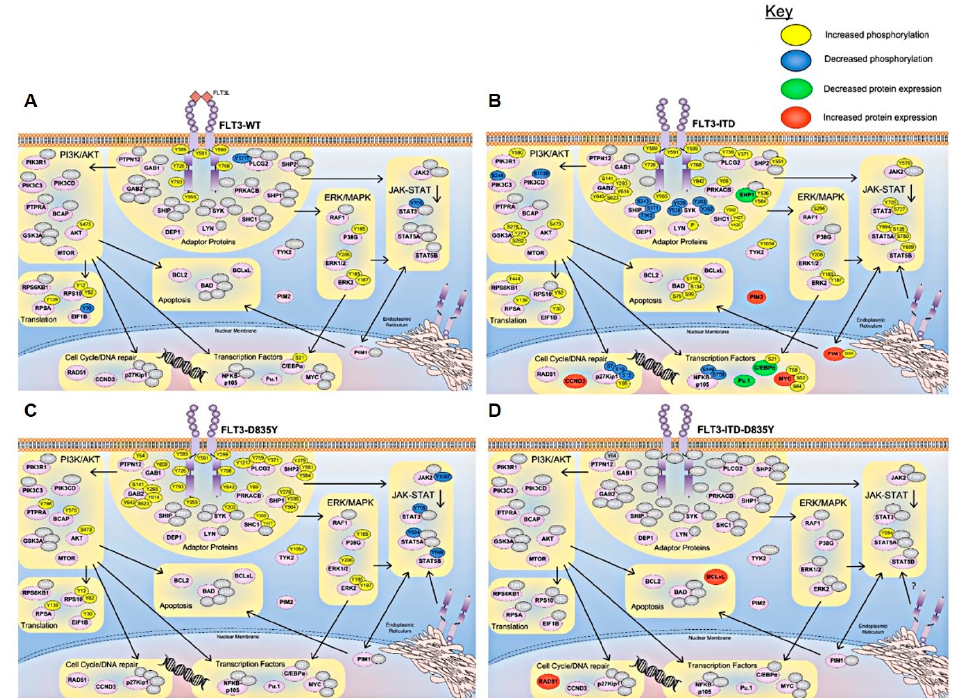
Figure 2. Canonical FLT3 and mutant FLT3 signaling pathways. Similar and divergent signaling pathways of wild-type and mutant FLT3 identified by functional genomic studies and large scale proteomic profiling experiments. ( A ) Upon binding of the FLT3 ligand (FLT3L), the FLT3 receptor undergoes a change in conformation and trans-autophosphorylation. ( B ) FLT3-ITD, ( C ) FLT3-TKD and ( D ) FLT3-ITD-TKD dual mutations lead to constitutive, ligand independent activation of the FLT3 receptor. Subsequent recruitment of adaptor proteins effects the activation of downstream kinase signaling pathways, such as MAPK, JAK-STAT, and PI3K. Coloring indicates activation of pathway phosphorylation or expression changes associated with the wild-type and mutant FLT3 receptor forms. Numbers indicate amino acid residues of the human protein sequence. Figure created using data from references [18,72,99–110].